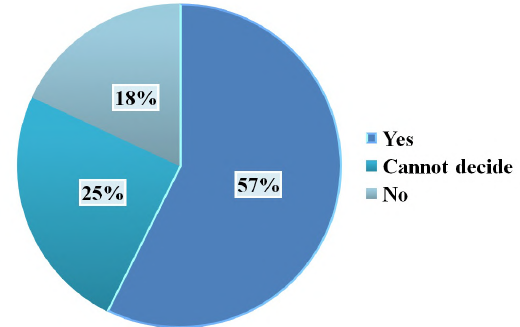
Figure 7: Percentage distribution of responses of physical education teachers by the criterion of their attitude to the use of augmented reality in the educational process to preserve the health of students and develop their motor skills, intelligence and creativity.